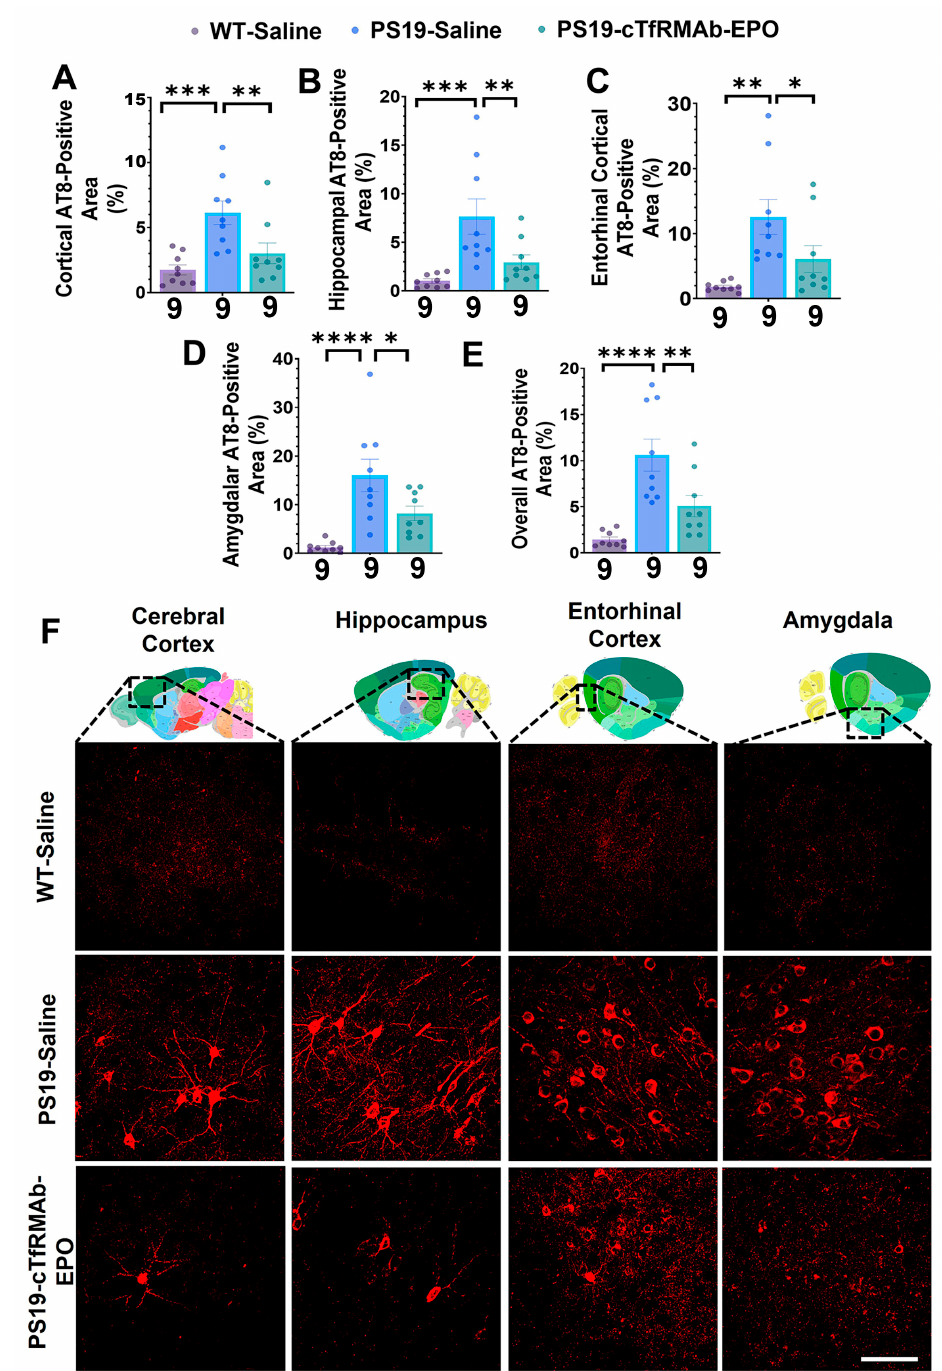
Figure 2. Effect of cTfRMAb-EPO on the pTau-positive area in the PS19 mice with AT8 immunos- taining. The AT8-positive area was significantly lower in the cTfRMAb-EPO-treated PS19 mice compared to the saline-treated PS19 mice in the ( A ) cortex, ( B ) hippocampus, ( C ) entorhinal cortex, and ( D ) amygdala. ( E ) The overall AT8-positive area, which is the average of all brain regions, was also significantly reduced with cTfRMAb-EPO. ( F ) Representative images of AT8-positive pTau with thumbnail brain section images adapted from the Allen Institute that show the cerebral cortex, hippocampus, entorhinal cortex, and amygdala. Data are presented as mean ± SEM of n = 9 per treatment group (shown below each column). One outlier was excluded from the WT-Saline and PS19- cTfRMAb-EPO groups. One-way ANOVA with Holm–Sidak’s post hoc test was used to compare to the PS19-Saline group. * p < 0.05, ** p < 0.01, *** p < 0.001, **** p < 0.0001. Scale bar = 100 µ